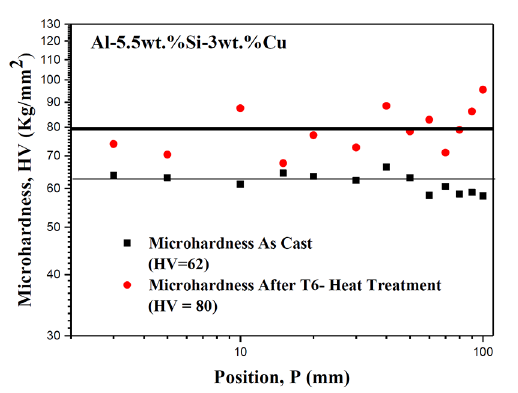
for the assumed 2